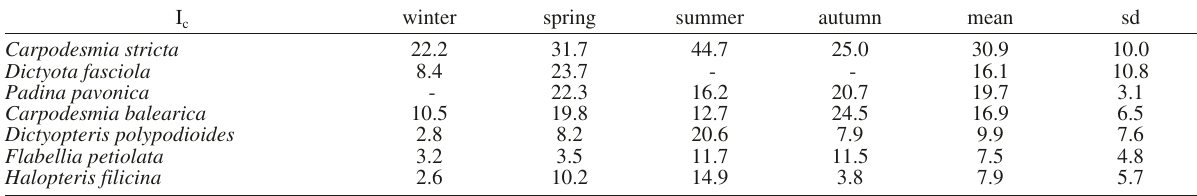
, in μmol photon m –2 s –1 ) for species and season. c